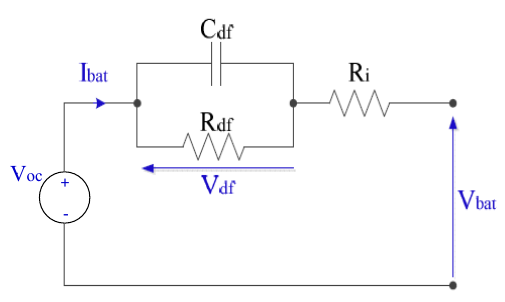
Figure 1. The first-order battery